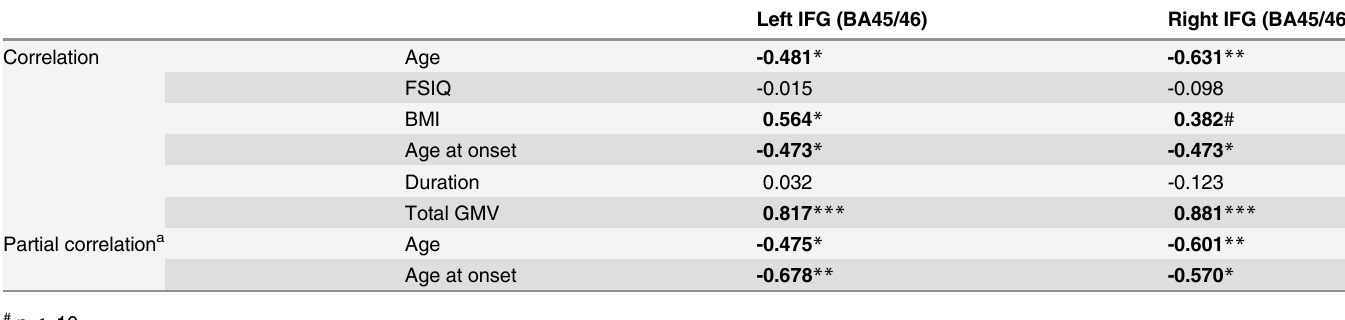
Table 4. Correlations between volumetric and clinical variables within the AN